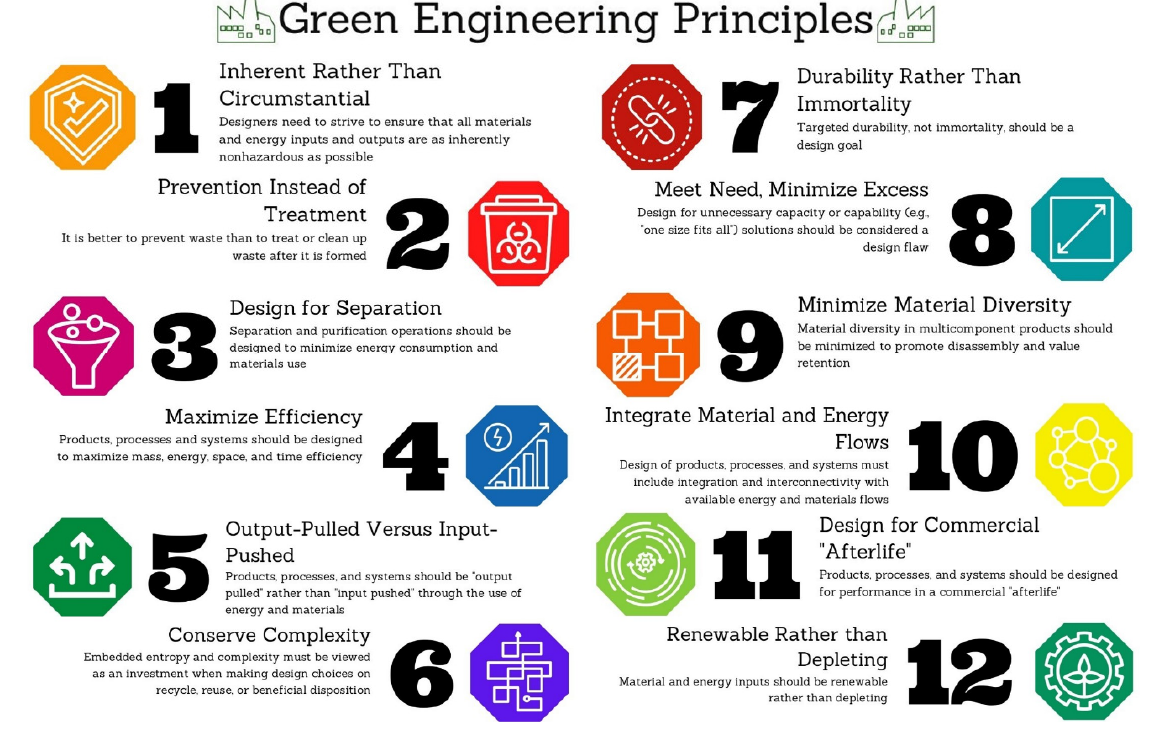
Figure 4. Green Engineering Principles (GEP, with information of [26]).